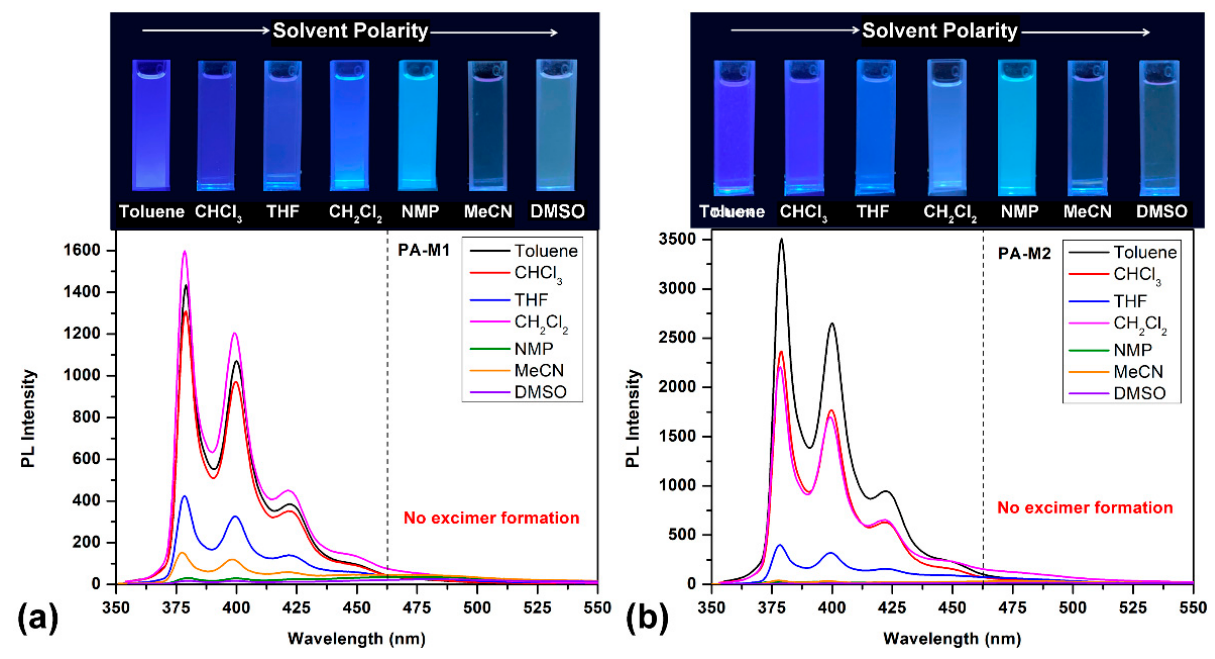
Figure 8. PL spectra of the dilute solution of model compound (a) M1 and (b) M2 (ca. 10 μ M) in solvents of various polarity. Photographs were taken under illumination of a 365-nanometer UV light.